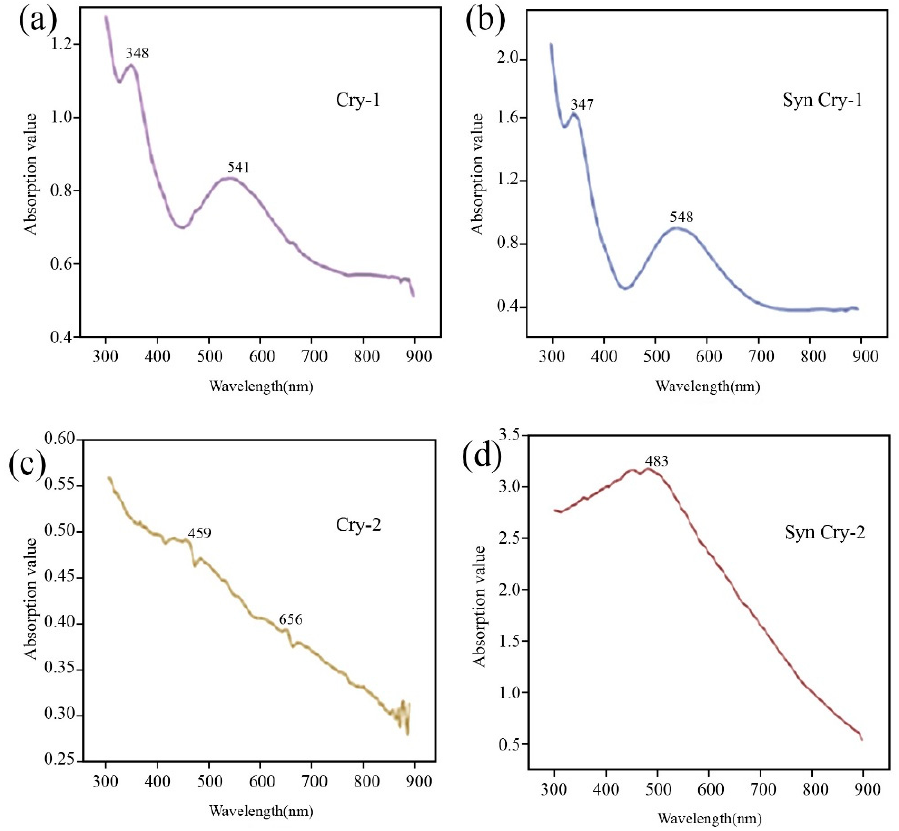
Figure 5. The UV-VIS spectra of Cry-1 ( a ), Syn Cry-1 ( b ), Cry-2 ( c ) and Syn Cry-2 ( d ) samples .